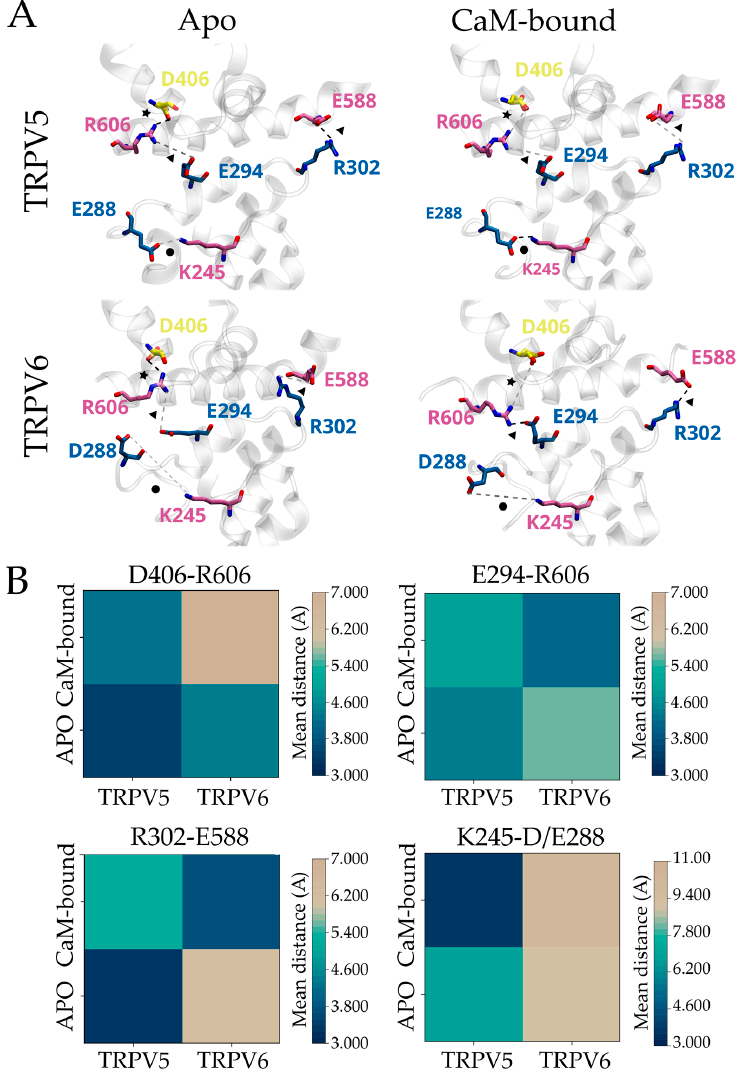
Figure 2. Evolutionary amino acid substitutions modulate the three-dimensional conformation of the HLH/S2-S3 linker/TDh inactivation motif in mammalian TRPV5 and TRPV6. ( A ) Representative structural arrangement of the three-dimensional inactivation motif of mammalian TRPV5 and TRPV6 in the apo/lipid-bound and Ca 2+/ CaM-bound conformations (PDBs; TRPV5 apo: 6DMR, TRPV5 Ca 2+ /CaM-bound: 6DMW, TRPV6 apo: 7S88, TRPV6 Ca 2+ /CaM bound: 6E2F). Residues located at HLH (blue), S2-S3 linker (yellow), TDh (mauve), and ARD6 (pink) contributing to interdomain interactions are highlighted. Interactions between HLH–TDh (triangle), HLH–ARD6 (circle), and TDh/S2-S3 linker (star) are highlighted. ( B ) Heat maps representing the average distance between the pairs of residues in panel A . Bars on the right of each heat map represent the color scale of the mean distance in the analyzed